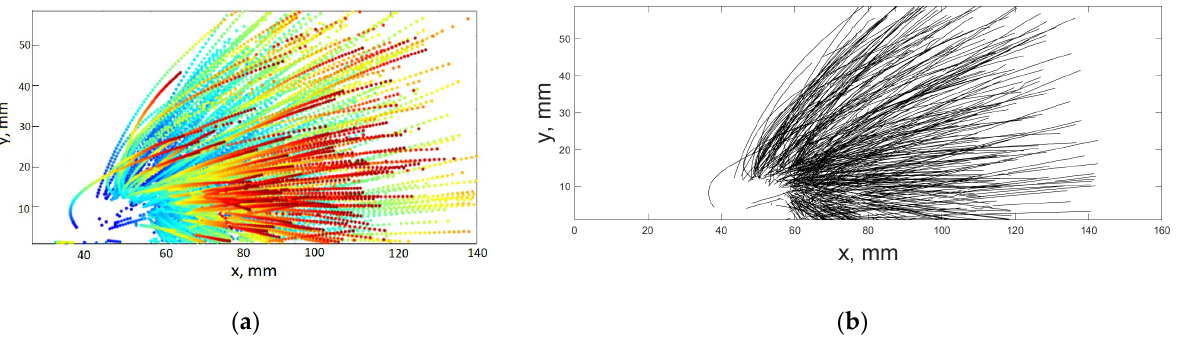
Figure 4. ( a ) Color from blue (first frame) to dark red (last frame) represented positions of all droplets on all frames in all frames one the record. ( b ) View on the all trajectories found in the entire video record.